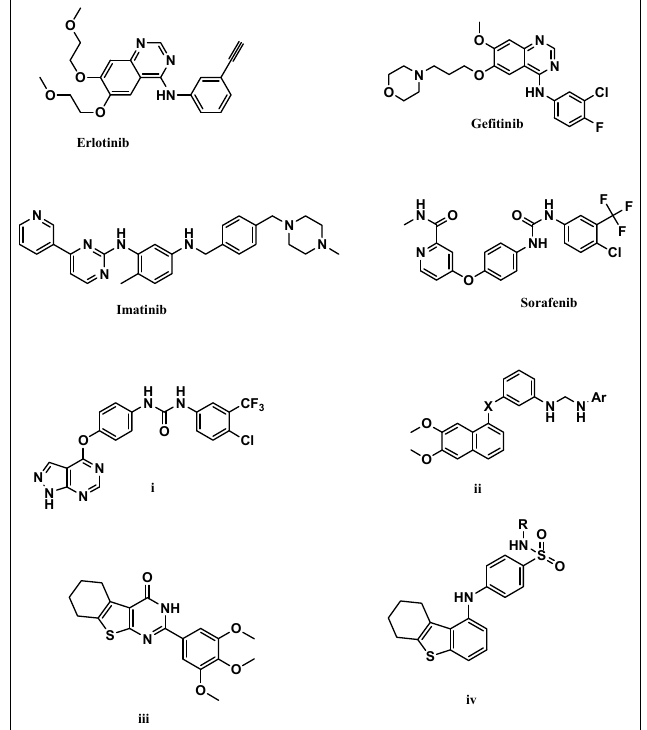
Figure 1. examples of reported kinase inhibitors. Figure 1. Examples of reported kinase inhibitors. Fms-like tyrosine kinase 3 (FLT3) is one of the interesting candidates of TKs that is important to maintain normal stem cell development as it supports hematopoietic stem cells proliferation and survival when activated by its ligand (FLT3L) [4,5].